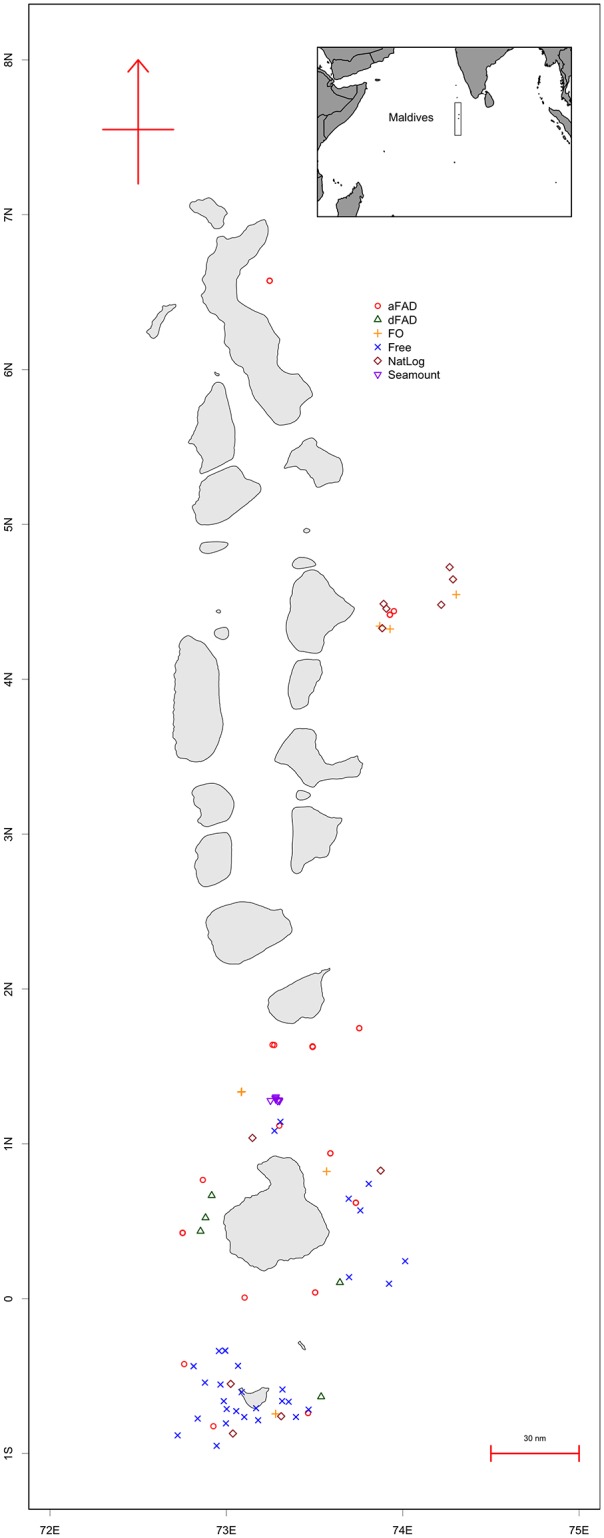
Map of Maldives.